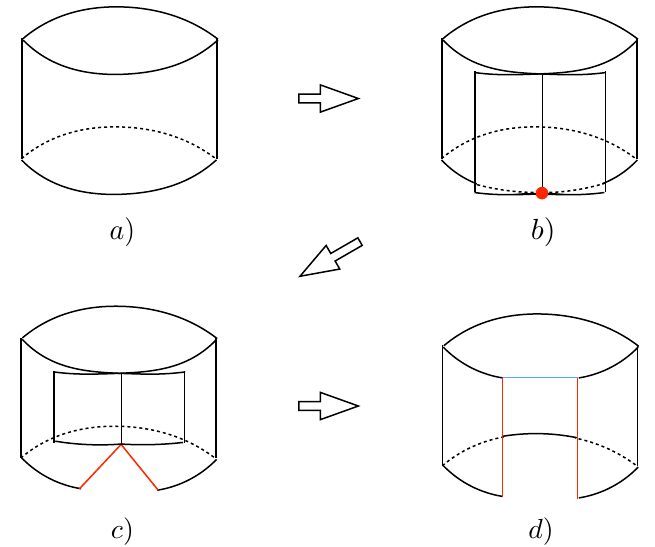
Figure 5. A transition from a ruled surface over a g = 1 curve to a Hirzebruch surface. The red point in the second (cid:12)gure is a blowup point on a nodal curve and the red lines in the third (cid:12)gure are the exceptional curves. Two proper transforms of the (cid:12)ber F in a blown up Hirzebruch surface are glued together along the nodal